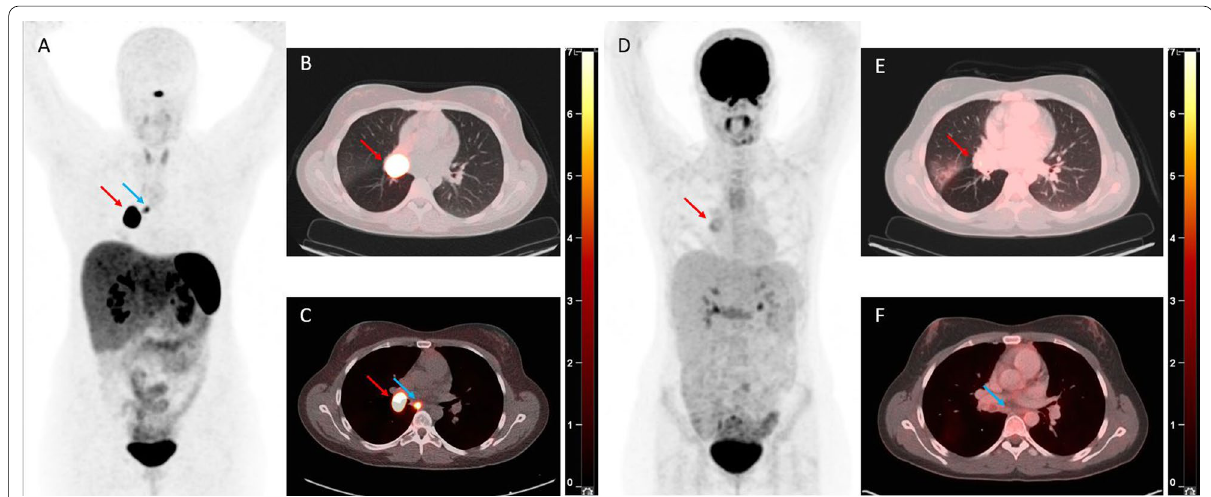
Fig. 4 21‑year‑old patient with a typical bronchial carcinoid (TC) who underwent a [ 68 Ga]Ga‑DOTATOC PET/CT scan showing two foci of intense tracer uptake on the MIP image (A) corresponding to the primary hilar tumour (red arrow, B) and to an infracarinal nodal metastasis (blue arrow, C), as well as an [ 18 F]FDG PET/CT scan showing only a limited tracer uptake in the tumour (red arrow, visible on the MIP image (A) and an axial fusion image (E)) and no increased tracer uptake in the infracarinal nodal metastasis (blue arrow, F). The SUV max values on [ 68 Ga]Ga‑DOTATOC PET/CT were 110 and 9.2 in the tumour and in the infracarinal lymph node, respectively, whereas those on [ 18 F]FDG PET/CT were 4.7 and 2.3 in the tumour and the infracarinal lymph node, respectively